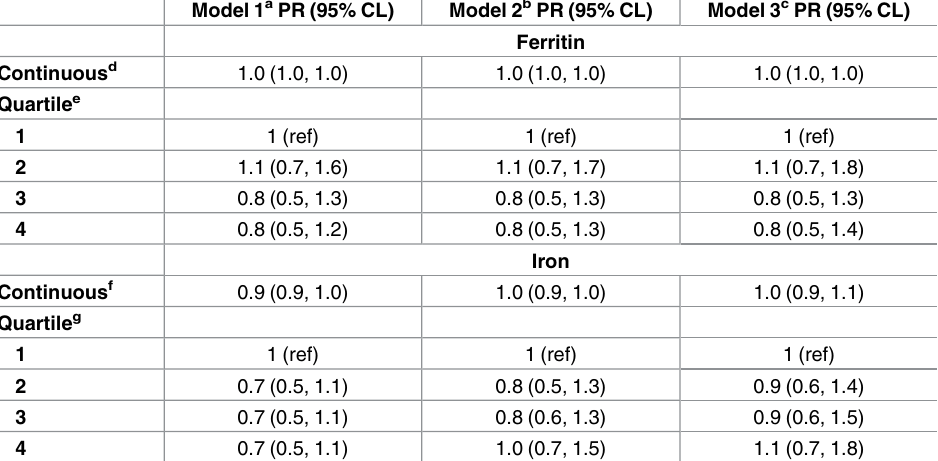
Table 2. Association of Ferritin and Iron with Pulmonary Hypertension in the JHS analysis sample, n =